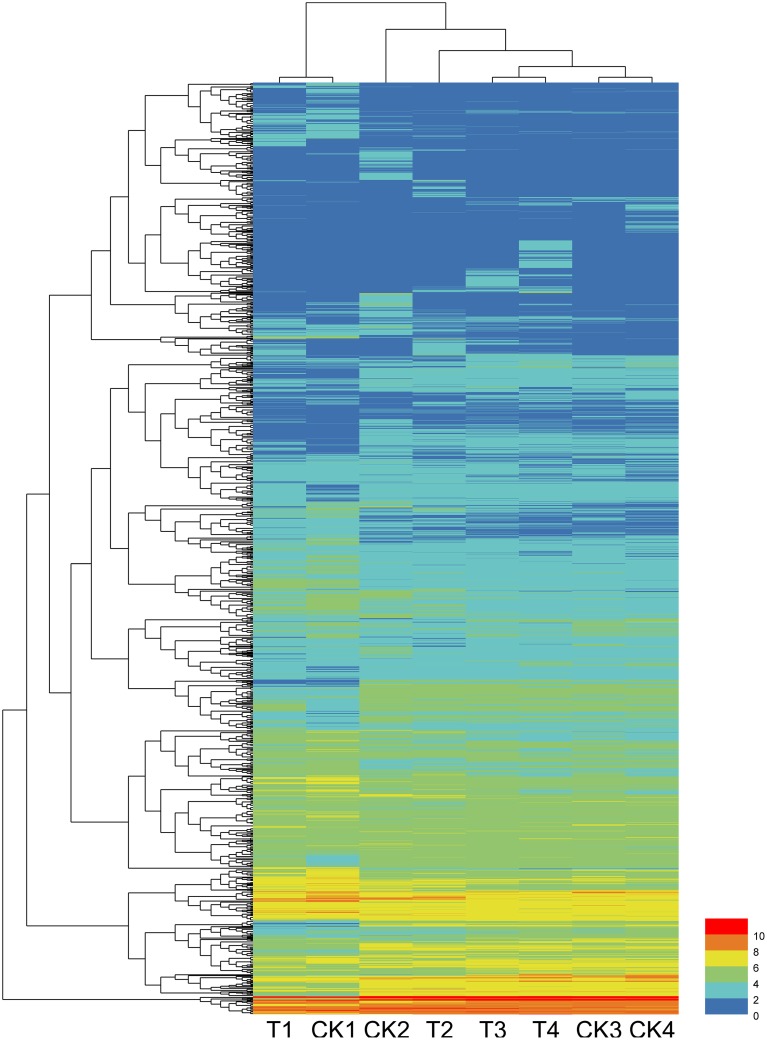
Heatmap of DEGs expression of inoculation and control samples at 12, 24, 48, and 72 hpi.